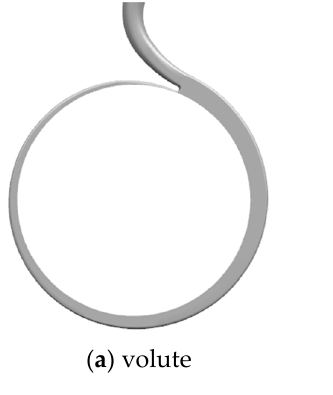
Figure 2. 3D model of full channels.